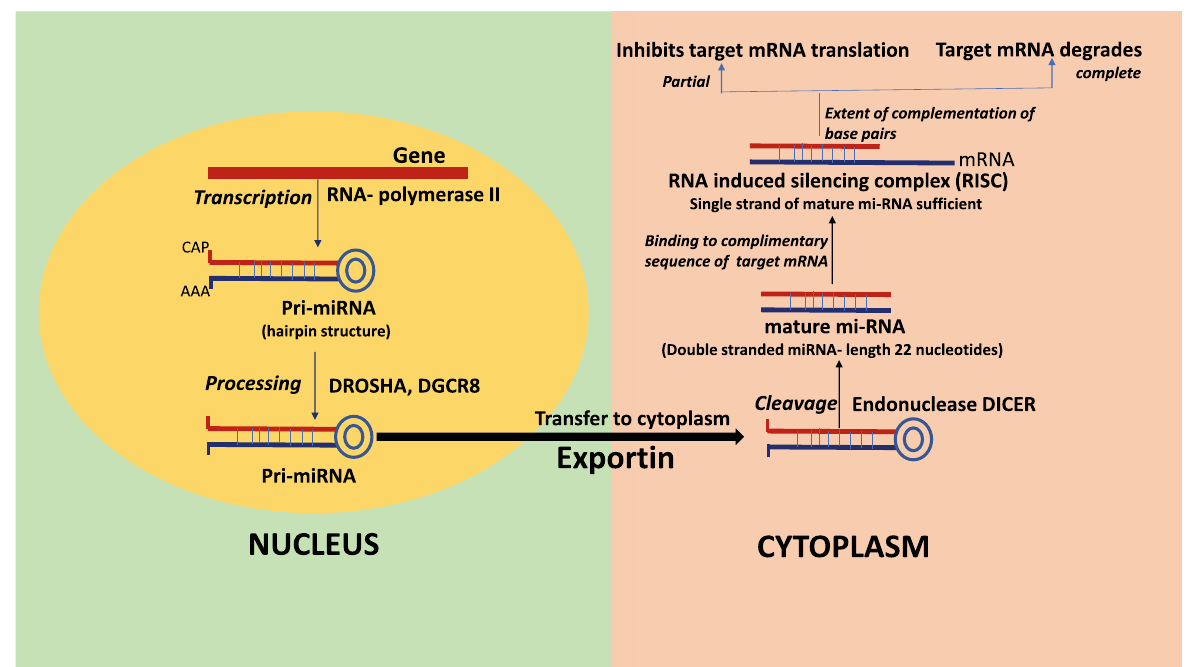
Fig. 1 A simplified diagram explaining the pathway of microRNA (miRNA) dependent gene expression. Shows processing of three different types of miRNA, pri-miRNA in nucleus, pre-miRNA migration to cytoplasm, processing of mature mi-RNA in cytoplasm. Inputs from [1,